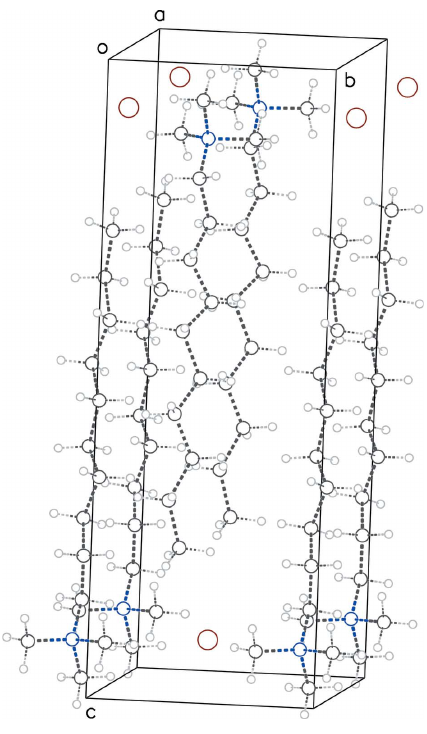
Figure 2 Schematic packing diagram showing one orientation of the statistically disordered n -decyl chains only. The alternating hydrophobic and hydrophilic regions of the structure are clearly evident.